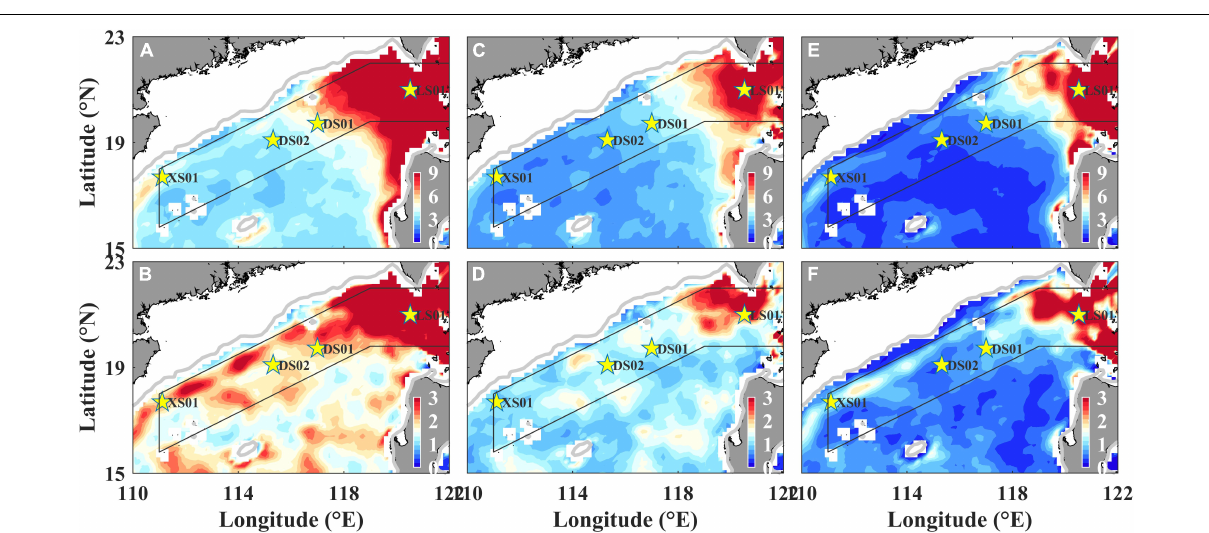
FIGURE 11 | Horizontal distribution of vertical integrated T 2 and T 4 . (A) Sum of T 2 and T 4 in 10–65-day period ( × 10 − 6 m 3 /s 3 ); (B) sum of T 2 and T 4 in 65–110-day period ( × 10 − 6 m 3 /s 3 ); (C) T 2 in 10–65-day period ( × 10 − 6 m 3 /s 3 ); (D) T 2 in 65–110-day period ( × 10 − 6 m 3 /s 3 ); (E) T 4 in 10–65-day period ( × 10 − 6 m 3 /s 3 ); and (F) T 4 in 65–110-day period ( × 10 − 6 m 3 /s 3 ) averaged from January 2003 to December 2012 (only positive values